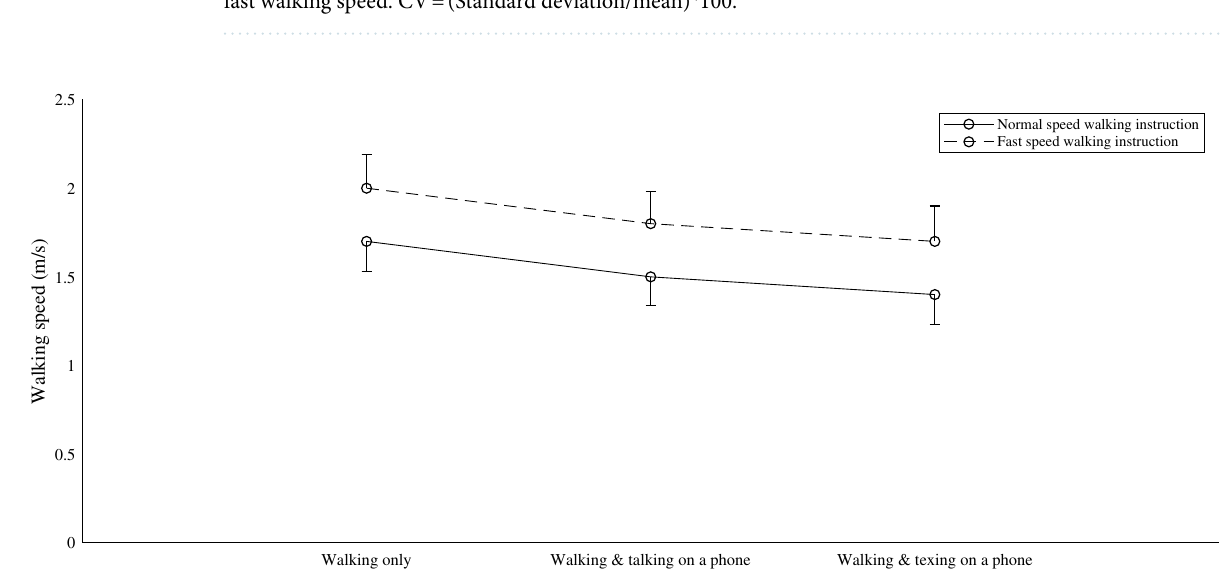
Table 4. Mean walking speed for each walking condition and the coefficient of variation (CV) value. Values are presented as Mean (± 1 standard deviation). NWS self-selected normal walking speed, FWS self-selected fast walking speed. CV = (Standard deviation/mean)*100.